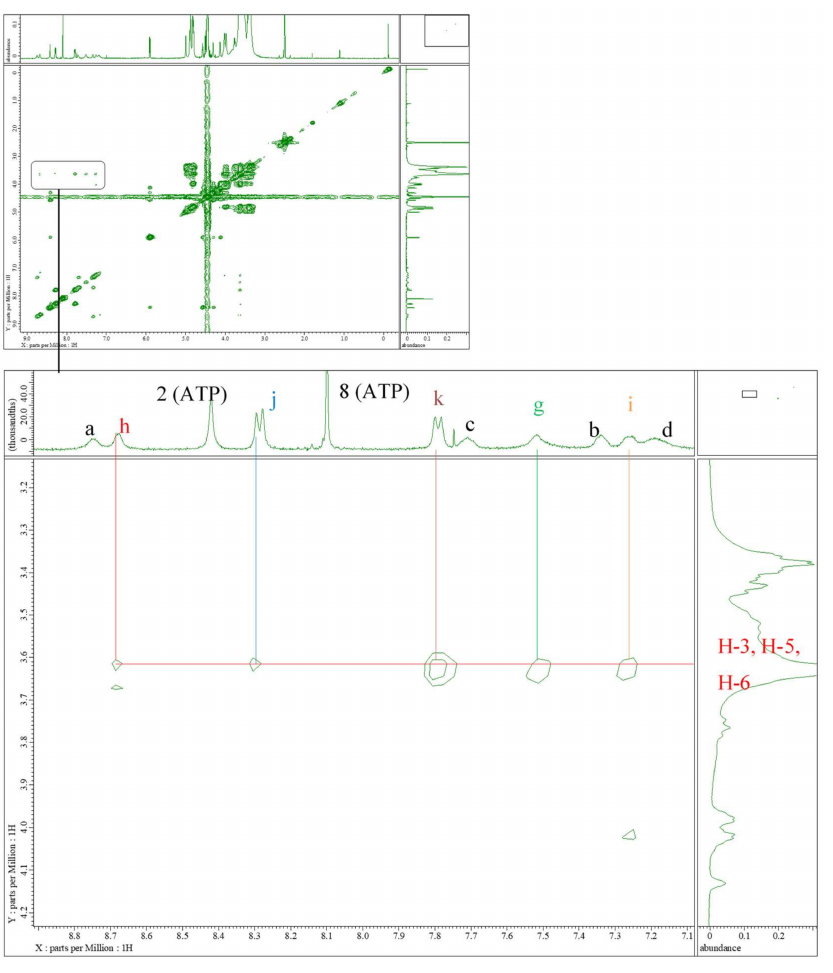
Figure 7. NOESY spectrum of 1-Zn/3-NH 2 - γ -CyD/ATP (22 °C, mixing time: 0.5 s, 160 scans).